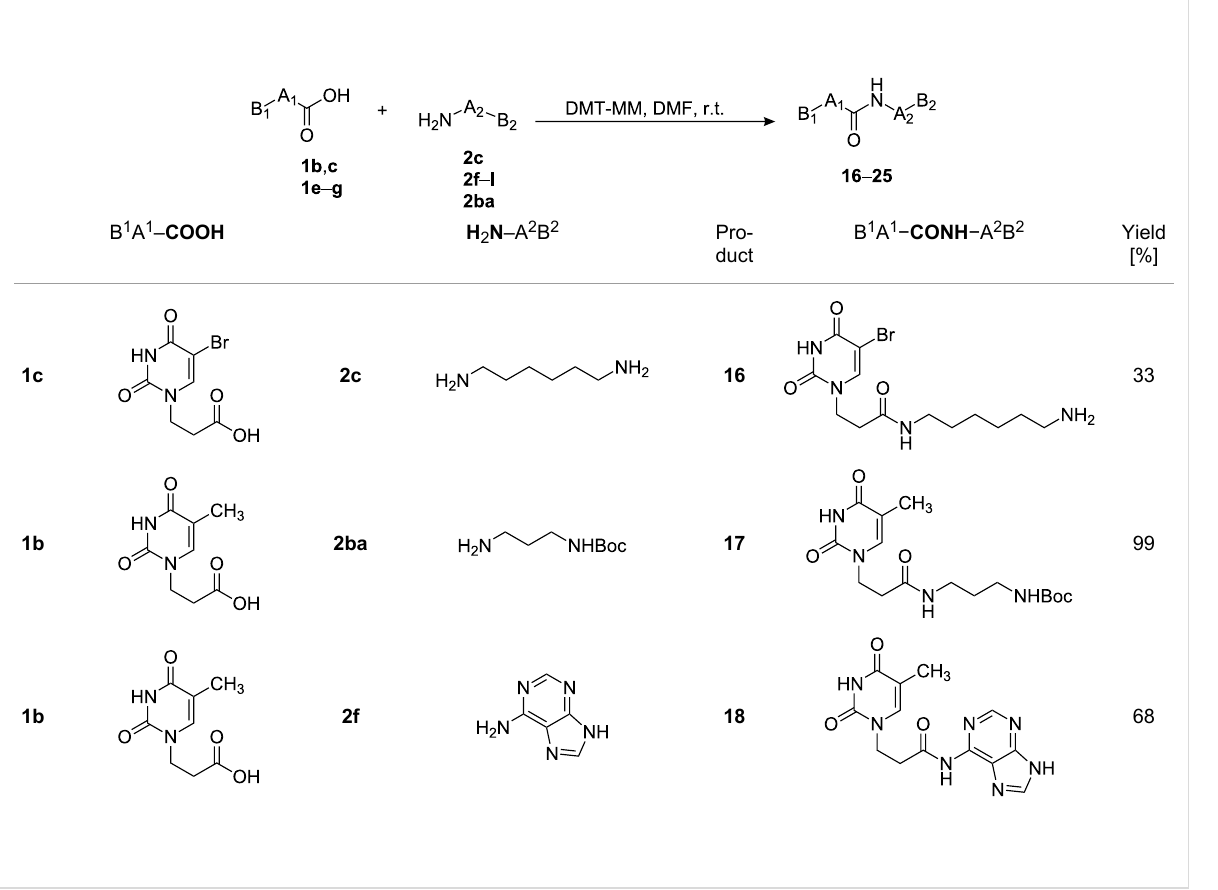
Table 2: Unsymmetrical α , ω -nucleobase amide-conjugated systems based on aliphatic or saccharidic linkages and their exemplary synthetic